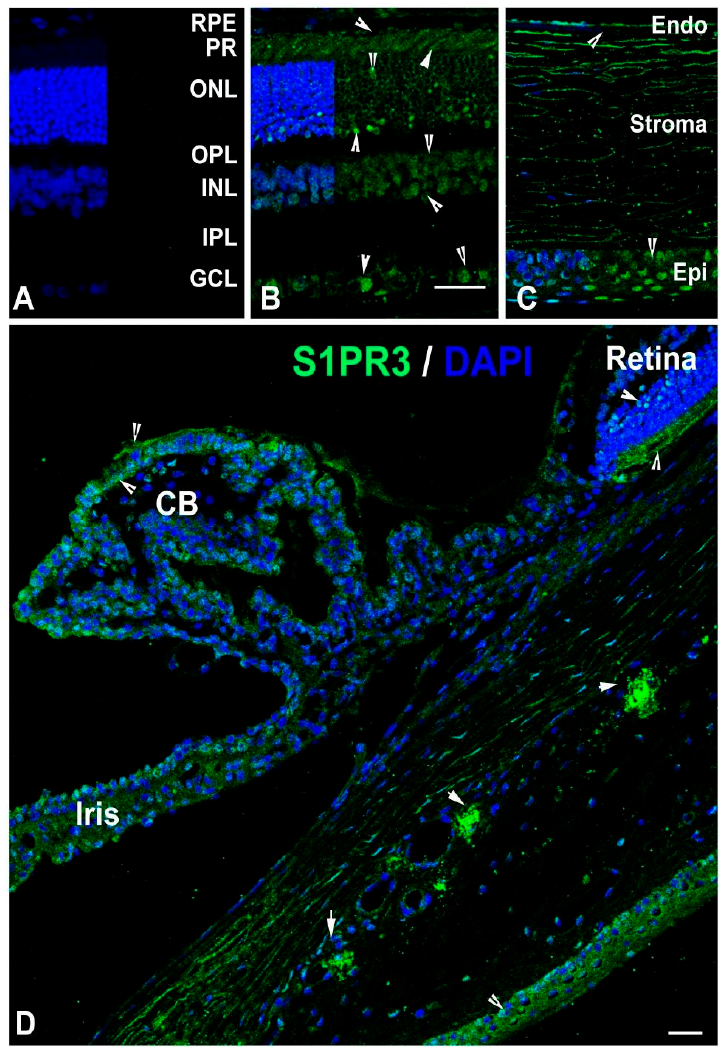
Figure 6. Localization of S1PR3 in adult (2–7 months old) rat ocular tissues. S1PR3 localization (green) was detected by anti-S1PR3 antibodies. ( A ) The rat retinal section in which the anti-S1PR3 antibodies were replaced with normal rabbit serum. The layers were marked and served as a negative control. ( B ) The retinal section of SD rat eye and S1PR3 localization in different layers is shown by arrowheads. ( C ) The corneal section of SD rat eye and S1PR3 localization in different layers is shown by arrowheads. ( D ) Partial anterior segment of SD rat eye containing ciliary epithelial cells, trabecular meshwork and Schlemm’s canal. The S1PR3 localization is shown by arrowheads. CB, ciliary body. RPE, retinal pigment epithelium. PR, photoreceptor. ONL, outer nuclear layer. OPL, outer plexiform layer. INL, inner nuclear layer. IPL, inner plexiform layer. GCL, ganglion cell layer. Endo, endothelium. Epi, epithelium. Scale = 25 µm.